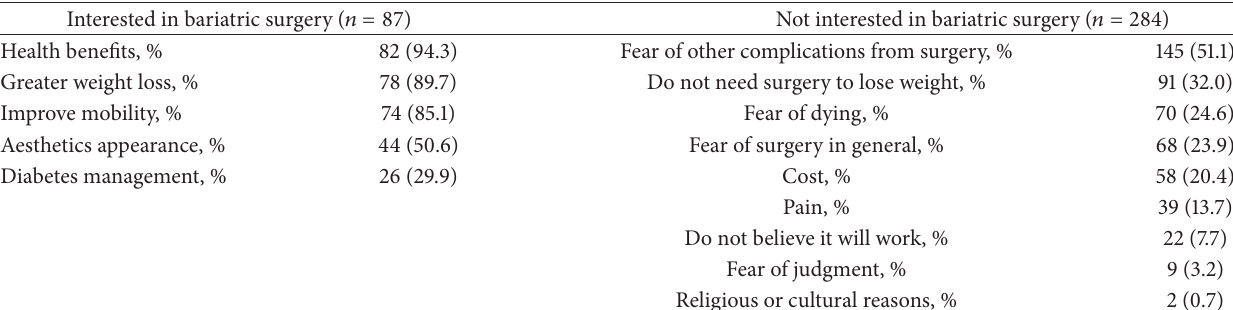
Table 2: Reasons respondents cited for being interested or not interested in bariatric